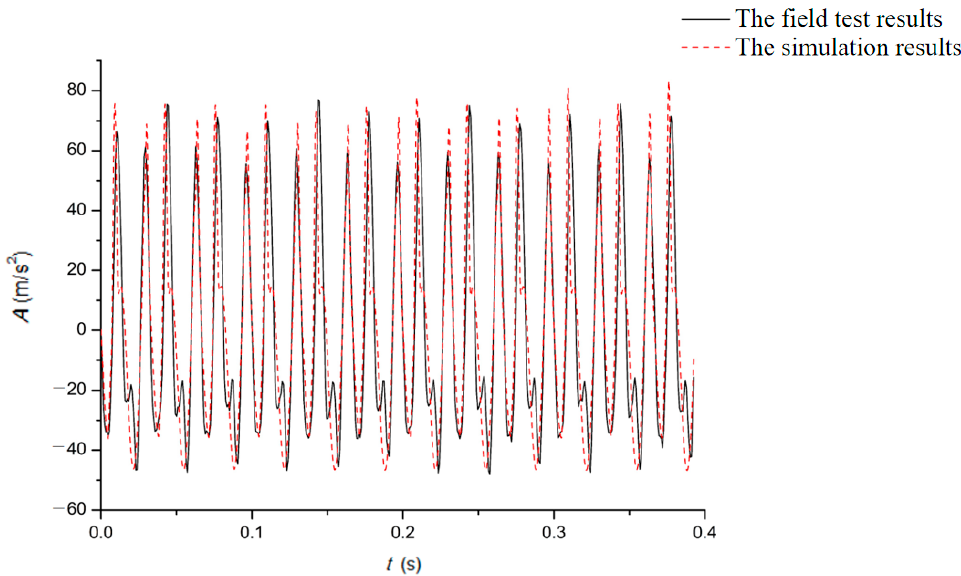
Figure 13. Comparison between field test results and simulation results.